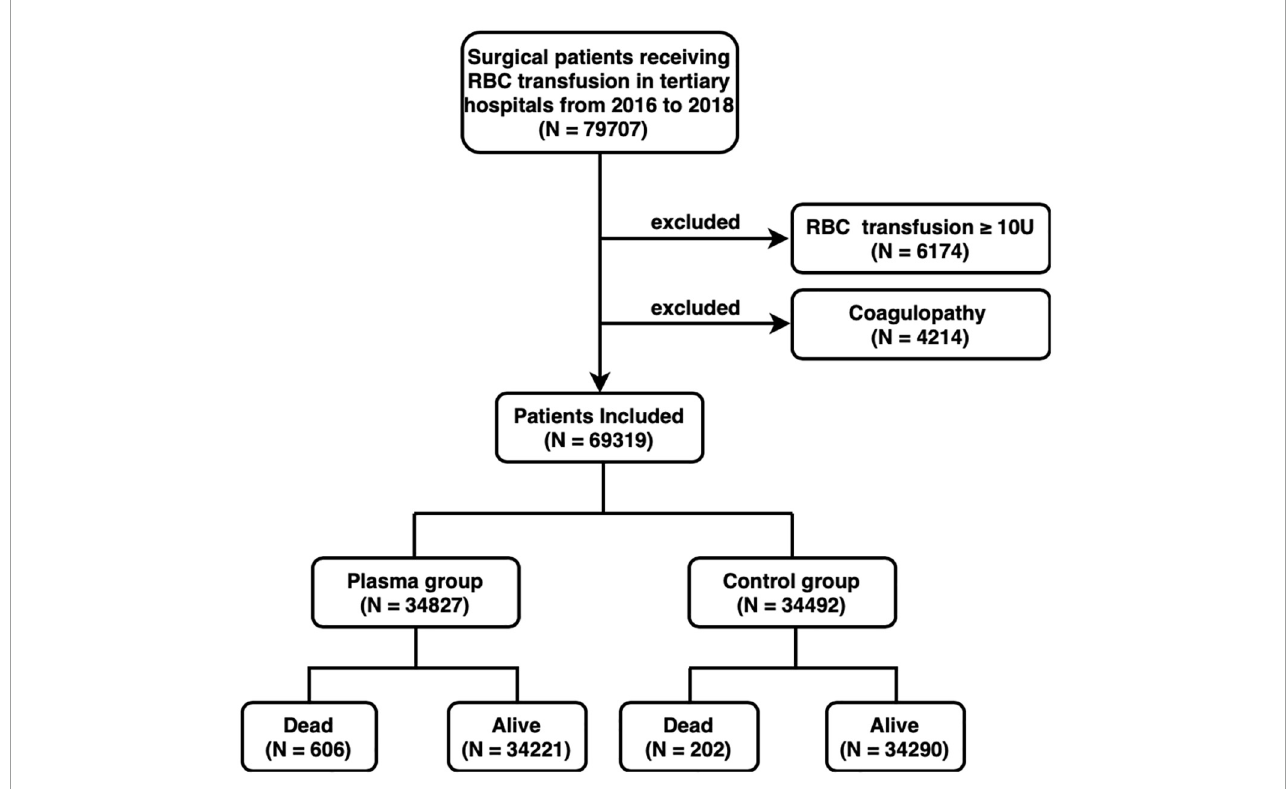
FIGURE1 Flowchart of patient selection. RBC, red blood cell; U, unit; FFP, fresh frozen